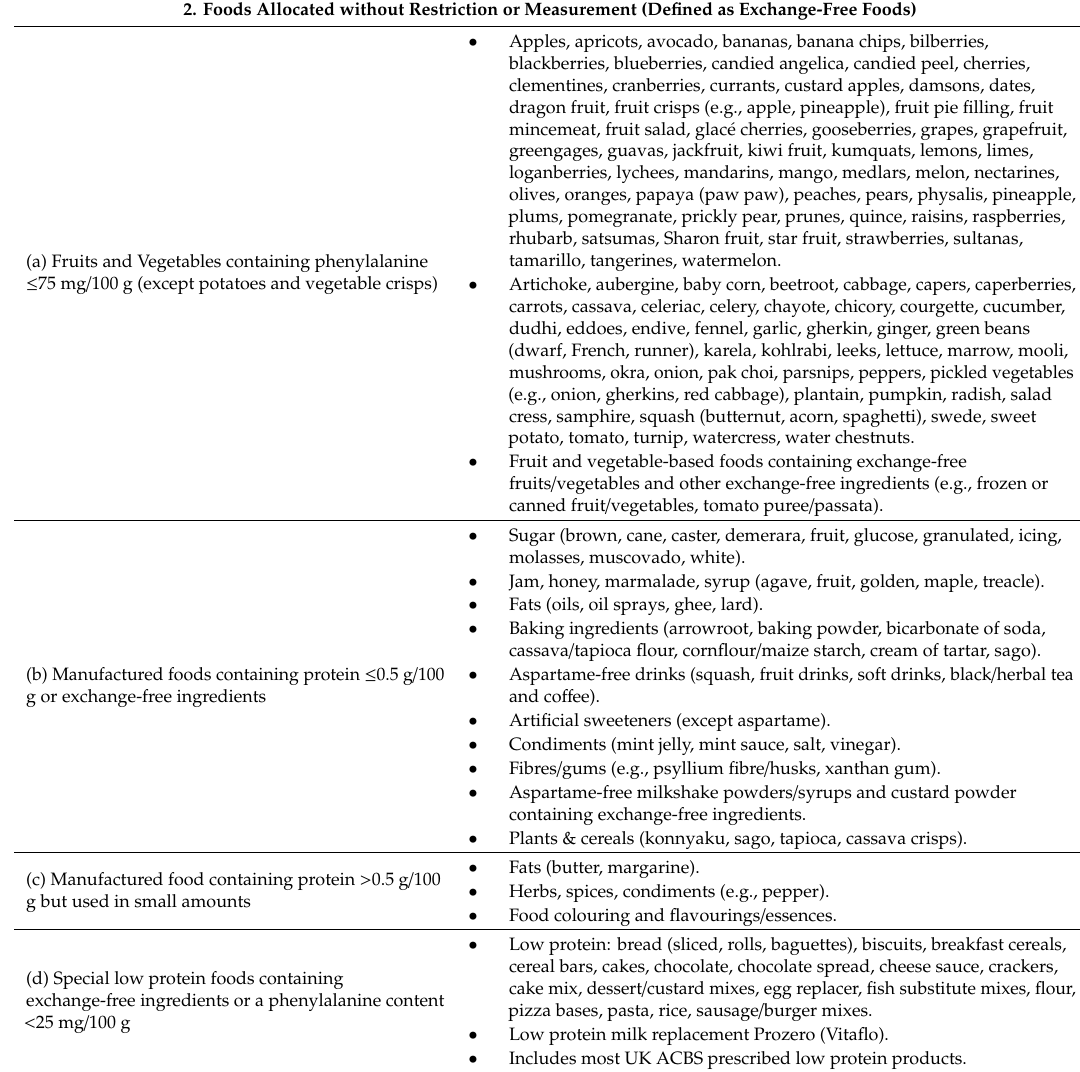
Table 2. Category 2: Foods allocated without